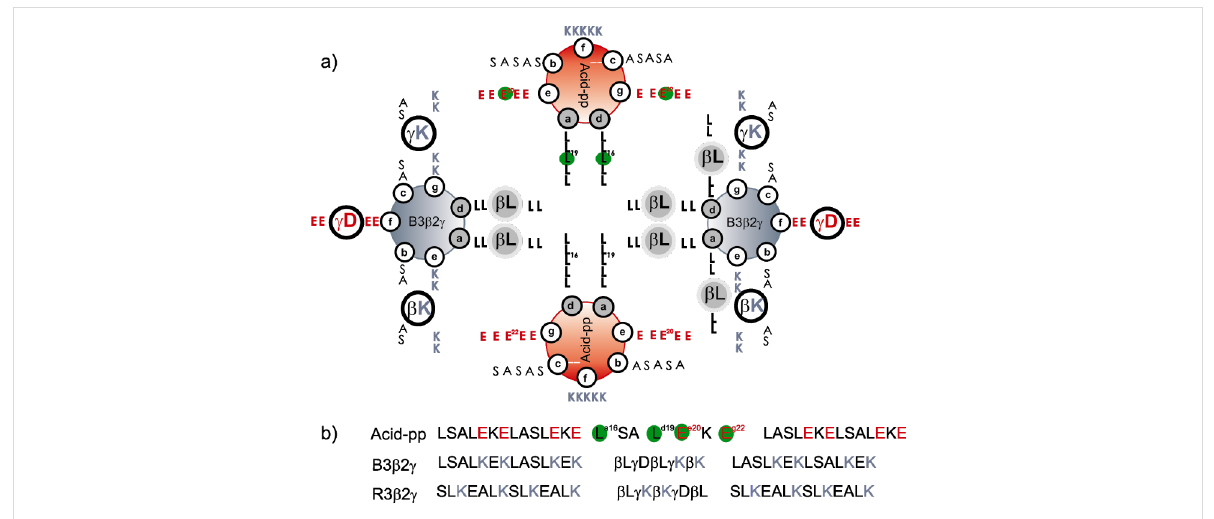
Figure 1: (a) Helical wheel representation of the tetrameric Acid-pp/B3 β 2 γ helix bundle, (b) sequences of Acid-pp, B3 β 2 γ , R3 β 2 γ . Red and blue letters indicate the acidic residues in Acid-pp and the basic residues in B3 β 2 γ and R3 β 2 γ , respectively. The randomized positions are designated by green